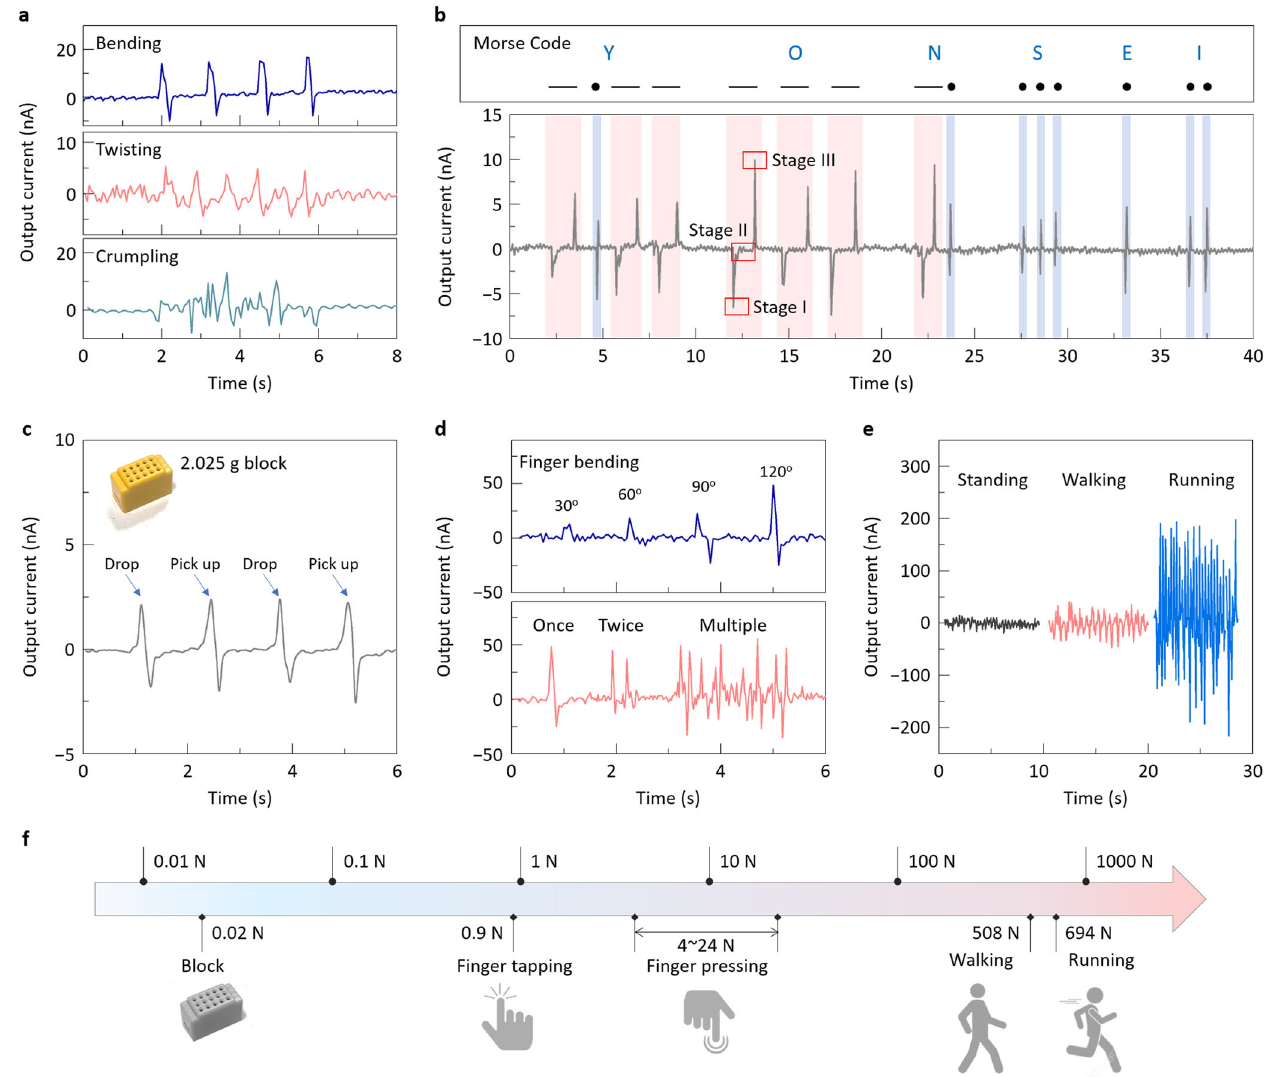
Fig. 5 Sensing performances of all-fabric-based pressure sensors. a Current-sensing performance of the 2/2 weft rib weave generator during manual bending, twisting, and crumpling motions. b Examples of Morse codes created by fi nger-pressing operations with three stages of operation: stage I for the negative signal, stage II for the null current, and stage III for the positive signal. c Generation of an output current by dropping and picking up a small block. d Output current signals produced by fi nger-bending with different bending angles (top) and the number of fi nger bends (bottom). e Current generated by foot motions of walking and running compared with that of the standing position. f Schematic illustration of various mechanical input sources for the wide pressure range of 10 − 2 to 10 3